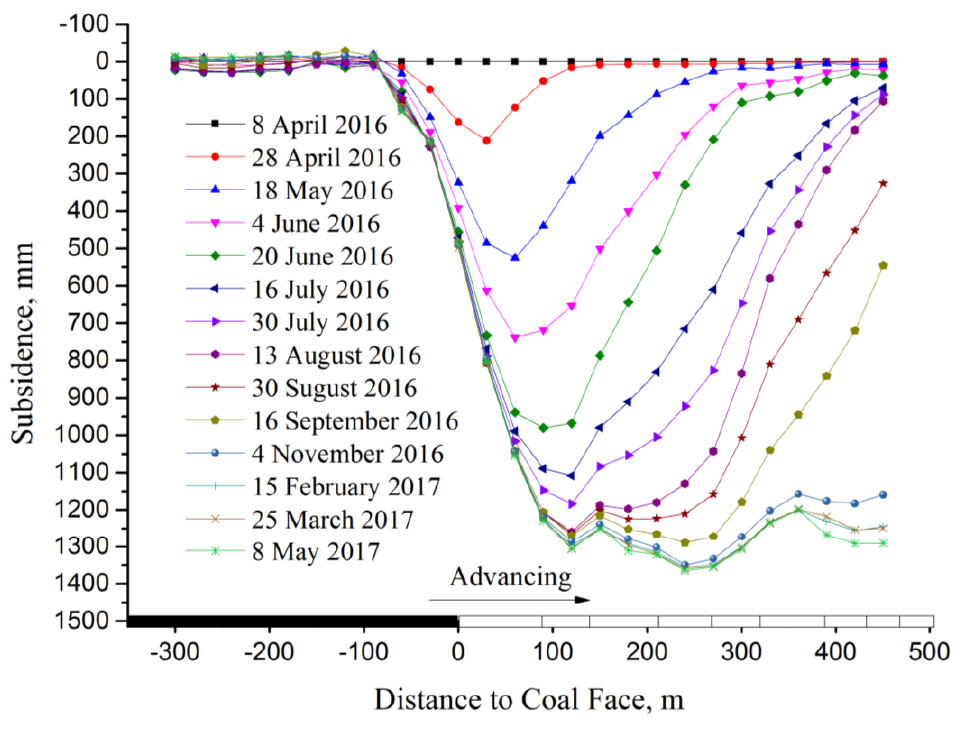
Figure 7. Development of dynamic subsidence profiles in longitudinal section as the face advances.